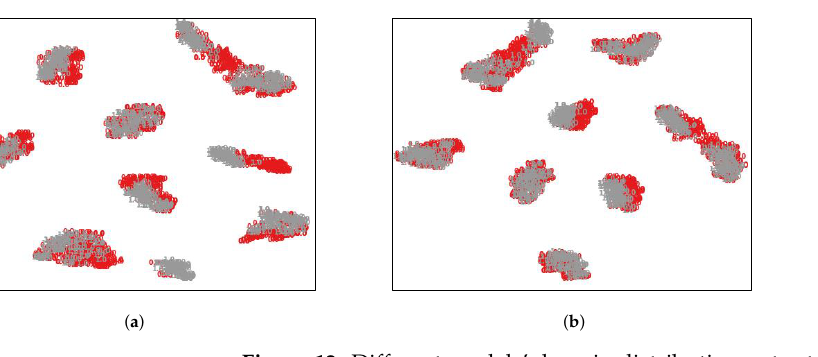
Figure 12. Different models’ domain distribution output of the test set from working condition 2. (SNR = − 4). ( a ) CNN; ( b ) DANN+MK-MMD; ( c )